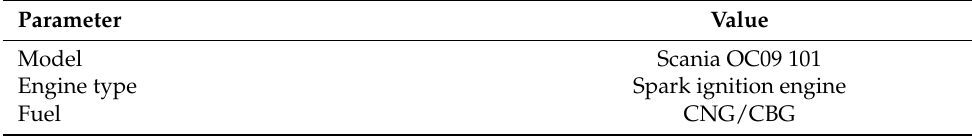
Table 2. Engine technical